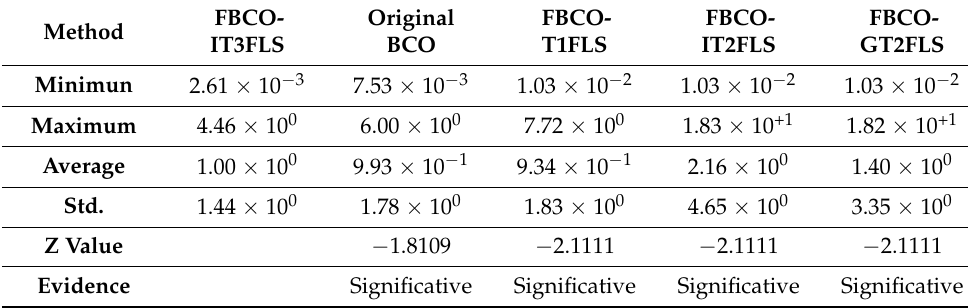
Table 5. Statistical test results for proposal FBCO-IT3FLS with